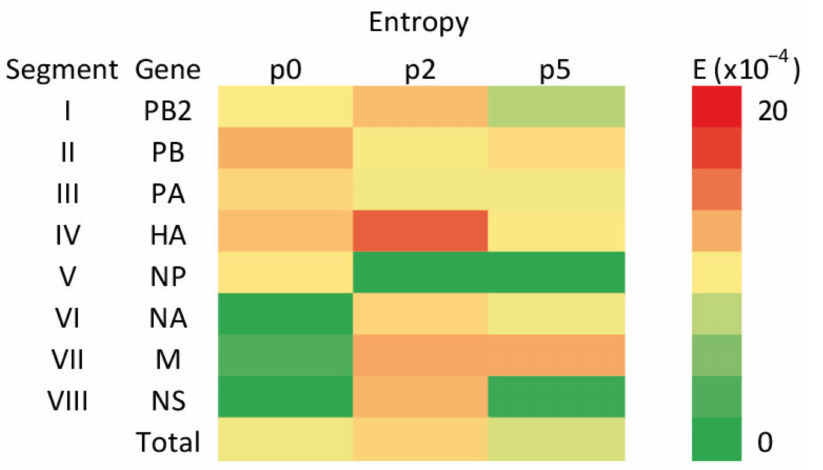
Figure 3. Heatmap of Shannon entropy for EIV genome segments and whole genomes, calculated from the frequencies of variants present in the virus population in nasal swabs (p0), passage 2 (p2) and passage 5